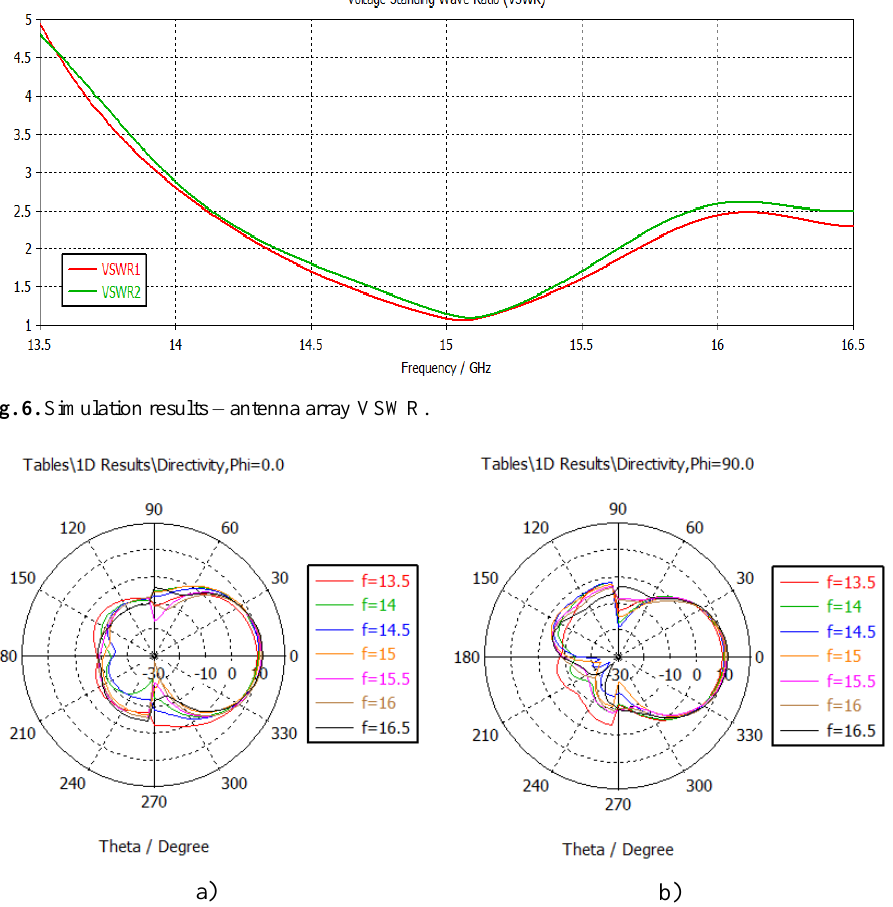
Fig. 7. Simulation results – emitter radiation